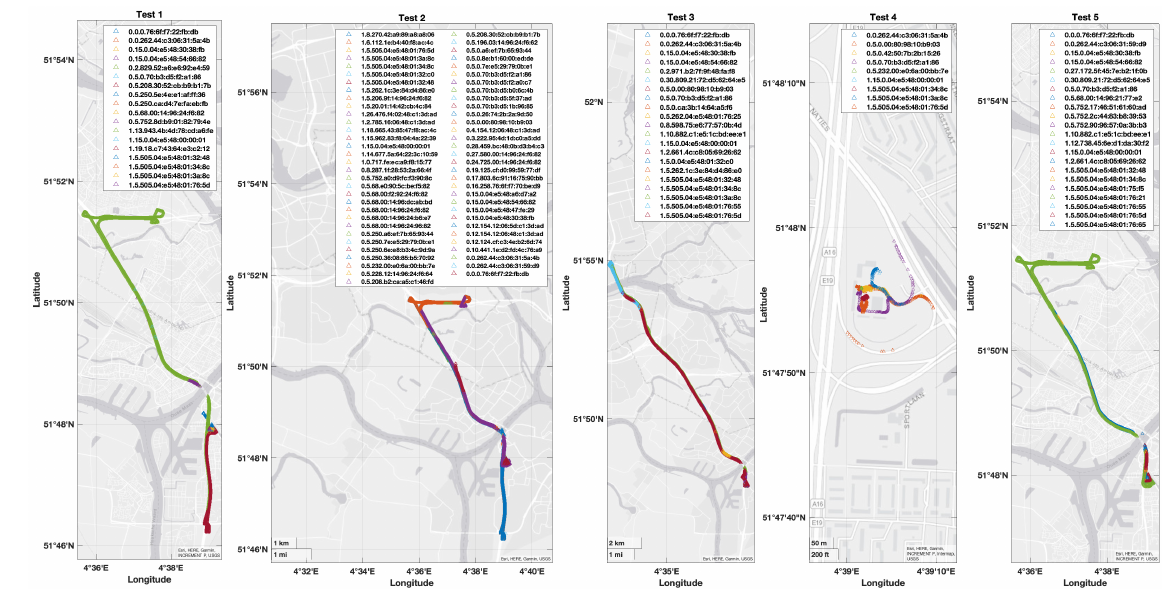
Figure 6. Applications being served by transmission showing the time to collision. Table 1. Test 1 details of the analyzed data from Wireshark tool. Test